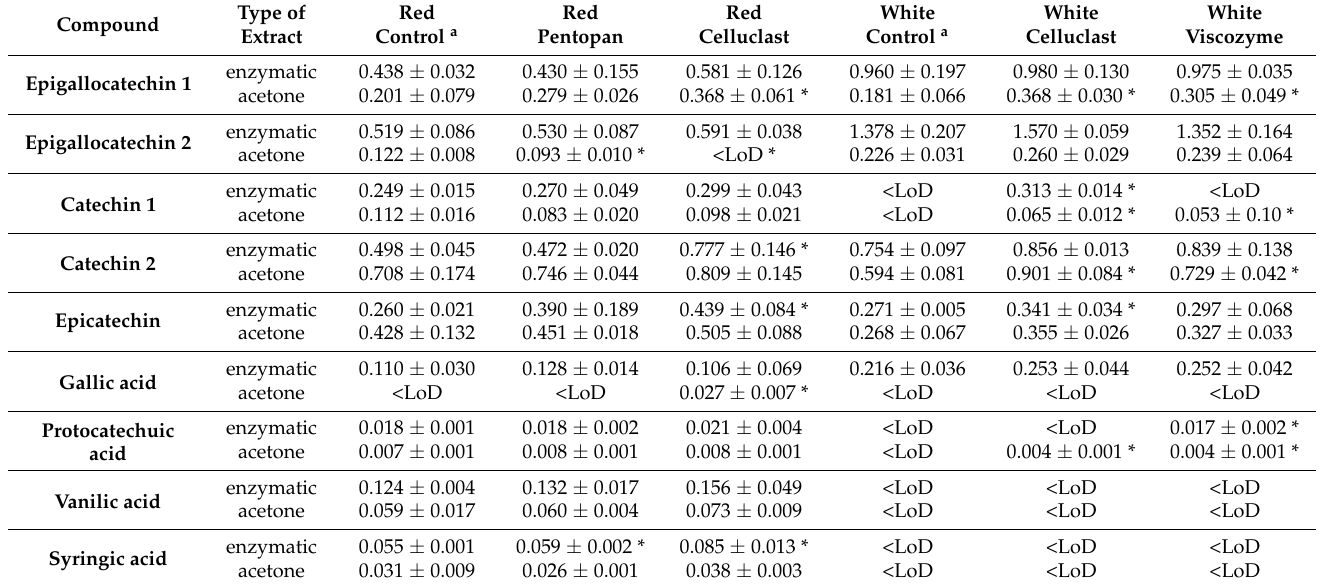
Table 2. Specific phenolic compound levels (mg/gDW) of selected enzymatic and acetone extracts of red and white grape pomace (2 h incubation, 2% w/w enzyme/substrate ratio) determined using HPLC-DAD analysis. Results are expressed as mg of compound per gram of pomace dry weight (DW). Data are the mean ± SD of three replicates ( n = 3). The star symbol (*) indicates a statistically significant difference (one-way ANOVA test followed by post-hoc two-tailed Tukey test, p < 0.05) between the enzymatic (water for control samples) or acetone data of a specific treated sample and the respective